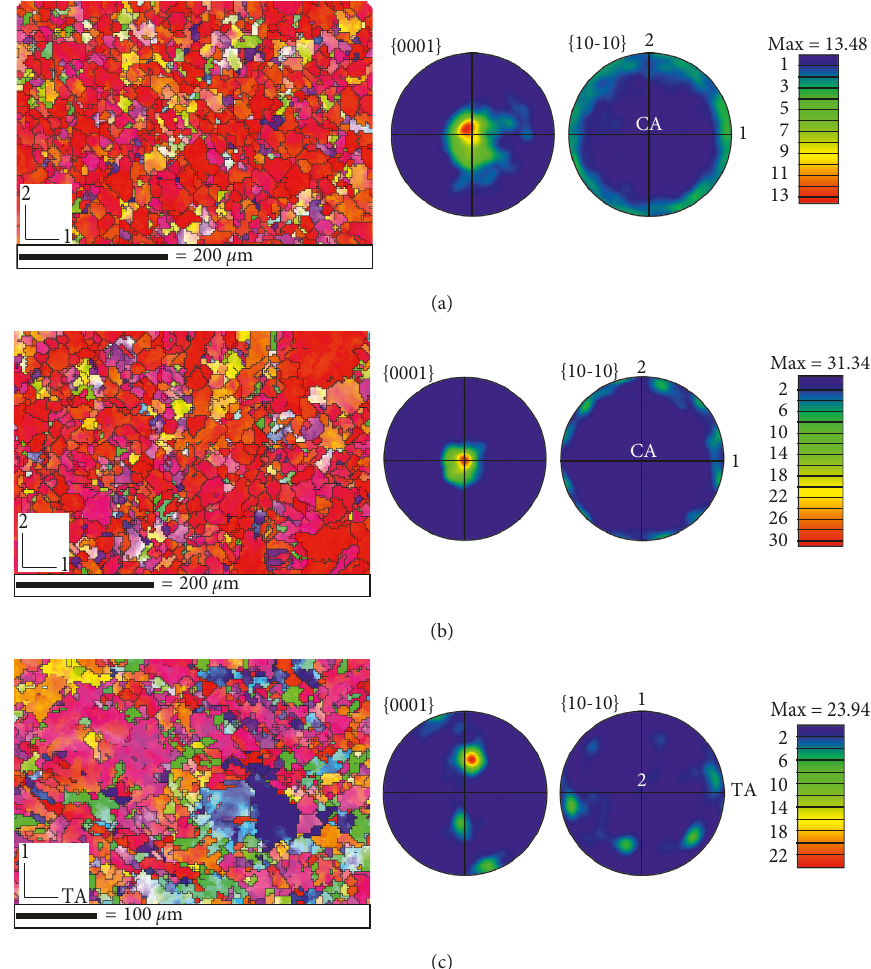
Figure 7: EBSD inverse pole figure (IPF) maps (left) and pole figures (right) showing texture of (a) CA0ED magnesium samples after simple compression collected in a plane normal to the compression axis CA. The IPF and pole figures in (c) illustrate the texture of r sample after uniaxial tensile test collected in the tensile plane. The labels 1 and 2 in (c) represent the lateral directions of the tension test. The color legend is the same as in Figure